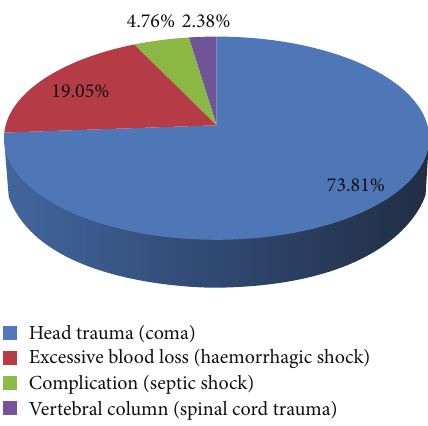
Figure 3: Mode of death in transport accidents among 50+ popula-